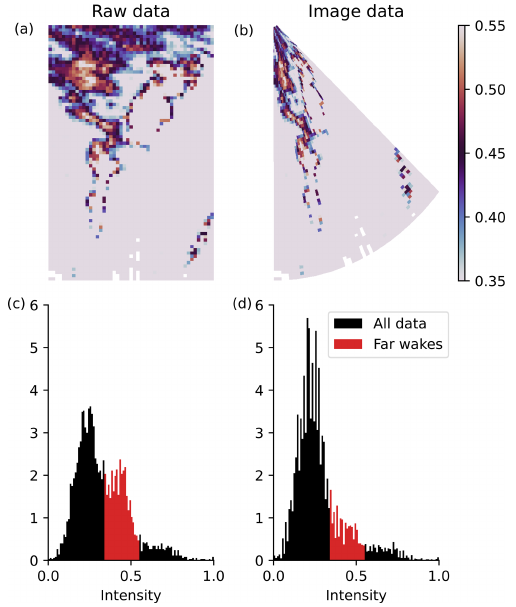
Figure A2. (a, b) Normalized wind speed data with far wakes high- lighted and (c, d) corresponding grayscale intensity histograms of the lidar scan